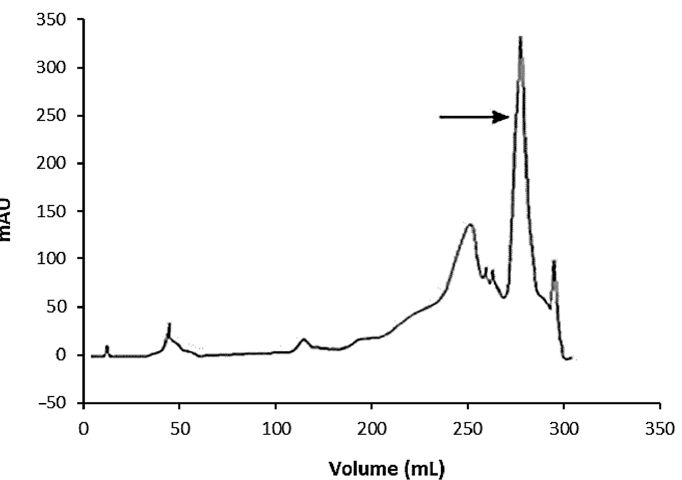
Figure 1. Elution profile of the anion-exchange chromatography of the sialidase from O129 on a DEAE cellulose column. The active peak was eluted with 0.1 M PBS at pH 7.5.